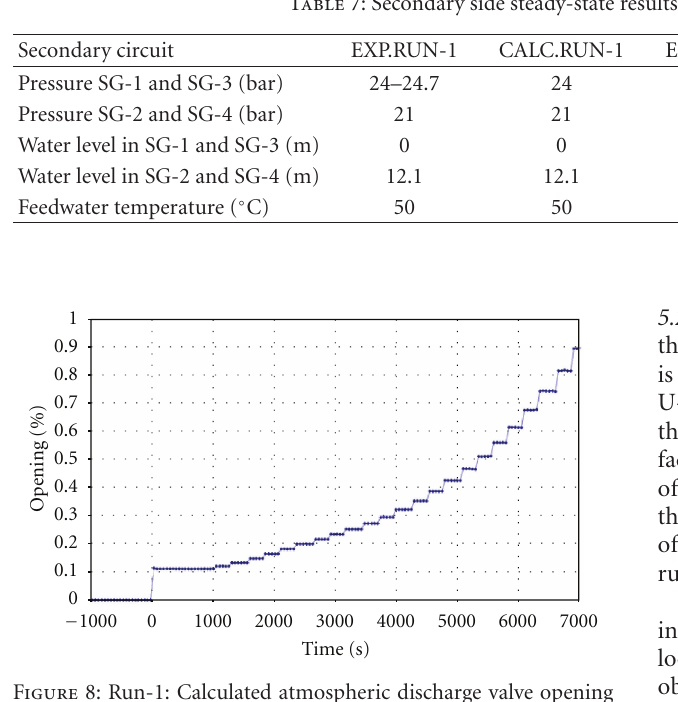
Figure 8: Run-1: Calculated atmospheric discharge valve opening evolution in the active SG.